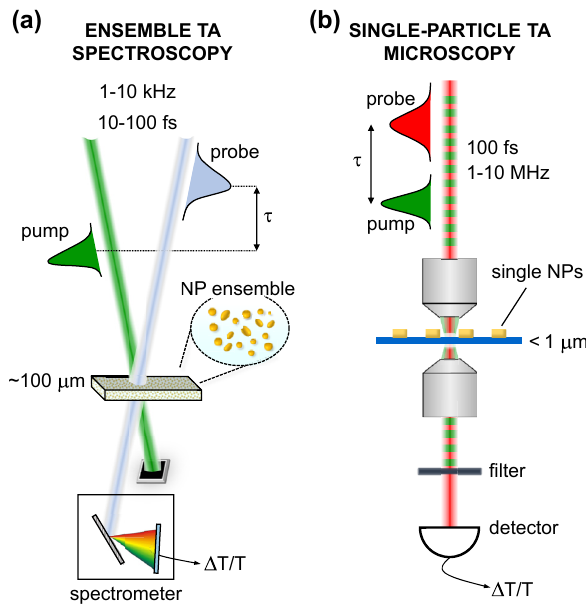
Figure 3: Experimental techniques for studying hot carrier dynamics in plasmonic nanostructures. (a) Sketch of a TA spectroscopy setup to study an ensemble of nanostructures. (b) Sketch of a TA microscopy setup to perform single-particle